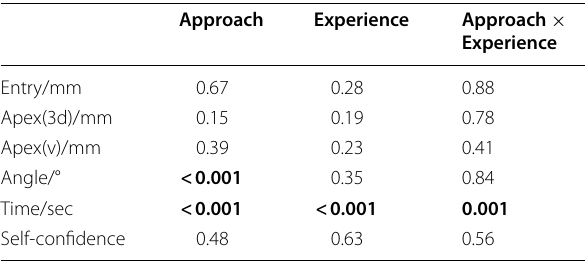
Table 2 Statistical significance of implant deviation, time and self-confidence considering approach, experience, and interaction of